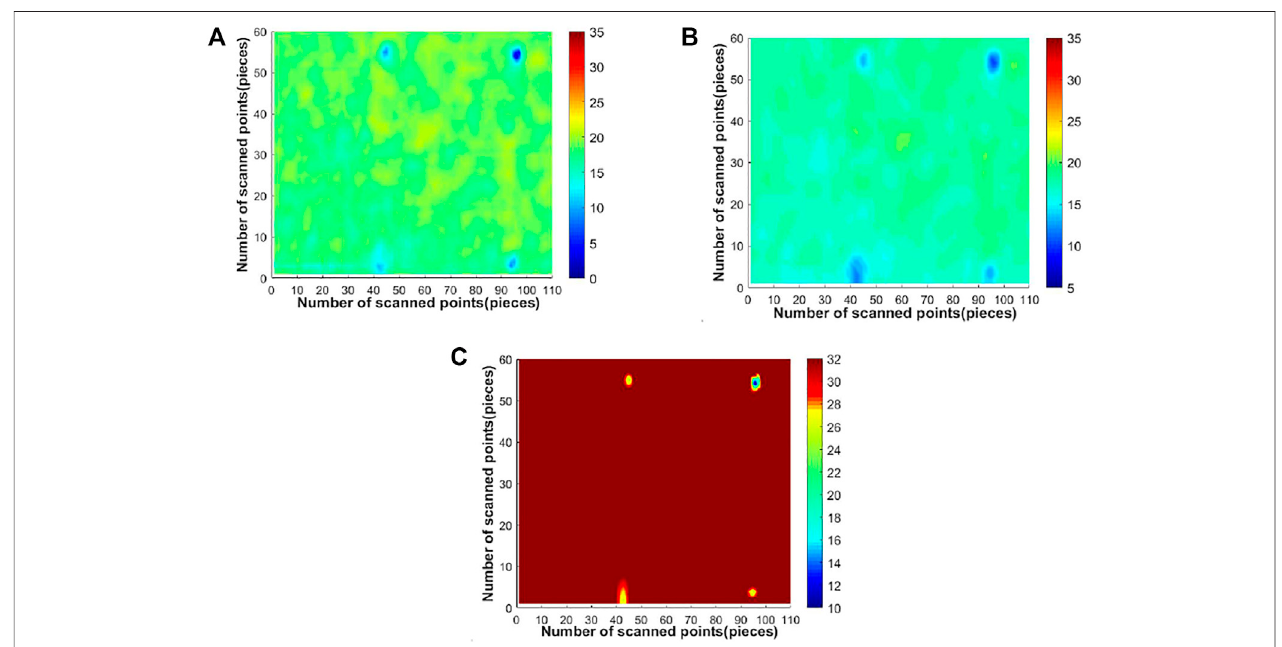
FIGURE 10 | Image of processing results of each method for adhesive debonding with a diameter of 3.0 mm in sample 3. (A) image of original detection, (B) Gaussian fi ltering, (C) method in this paper.